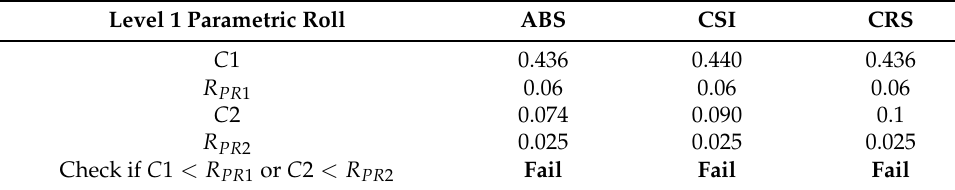
Table 22. Level 2 assessment of parametric roll failure mode for the C11 container ship.